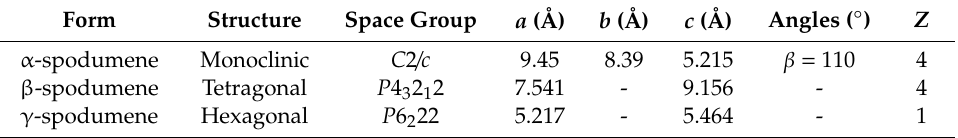
Figure 9. Crystal structures of spodumene. ( a ) α-spodumene, ( b ) β-spodumene, ( c ) γ-spodumene. Red: Oxygen. Yellow: Silicon. Blue: Aluminum. Green: Lithium. Note: The lattices images were obtained with the display module of the Jade2010 TM software. At a macroscopic level, α-spodumene appears as a very hard rock. It is compact and difficult to cut or grind while β-spodumene appears as a dusty material with a low resistance to grinding. At a microscopic level, α-spodumene appears as a compact material made out of multiple layers stacked on top of each other while β-spodumene presents many cracks on its particles, which make its structure more random.